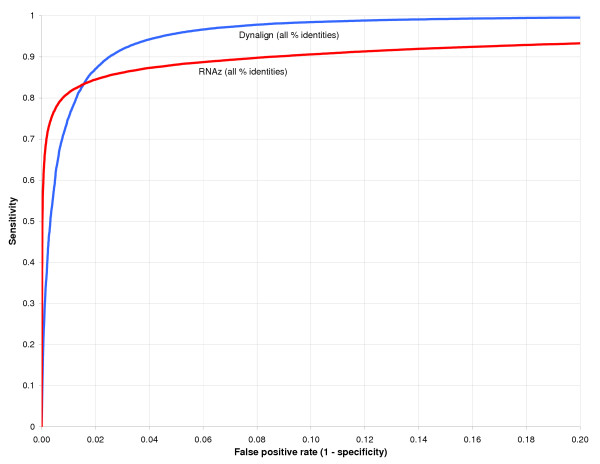
Comparison of the Dynalign/LIBSVM classifier with RNAz for sequence pairs of all identities. ROC curves for the Dynalign/LIBSVM classifier (blue) and RNAz (red), both based on a test set of 38,069 5S rRNA sequence pairs, 52,470 tRNA sequence pairs, plus two negative sequence pairs generated from each real sequence pair – one by a columnwise shuffle of a global alignment, one by an Altschul-Erikson dinucleotide shuffle of each sequence in the pair separately, yielding 90,539 real trial sequence pairs and 181,078 negative trial sequence pairs.